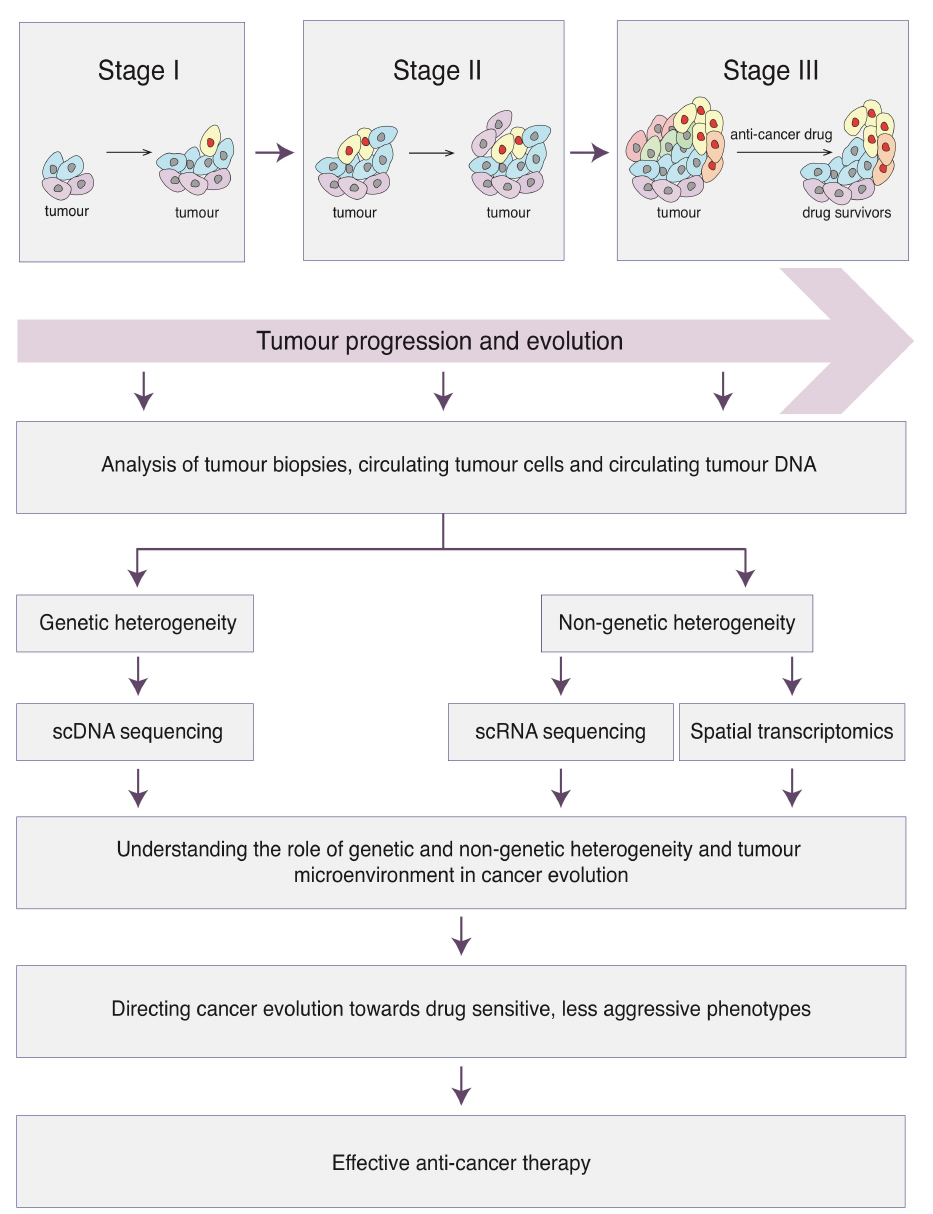
Figure 5. Novel systematic experimental approaches—powerful tools to diagnose cancer and monitor its progression. Tumours are rapidly-changing constantly-evolving open ecosystems. This feature of cancer development significantly affects the efficacy of anti-cancer therapy and patient outcomes. Therefore, it is crucial to monitor the dynamic changes taking place within a tumour along its development and upon drug treatment. Emerging experimental approaches that allow extraction and enrichment of circulating tumour cells and circulating tumour DNA may facilitate systematic analysis of tumour development at different stages of its progression. Furthermore, novel molecular biology technologies such as single-cell RNA and single-cell DNA sequencing as well as spatial transcriptomics provide an integral and more complete view on complex intra-tumour architecture and the dynamic changes taking place along cancer development. Overall, these may allow the design of more effective personalized therapeutic paradigms. The colour of the nuclei depicts a defined genotype; the colour of the cytoplasm shows distinct phenotypes that may result from genetic and non-genetic